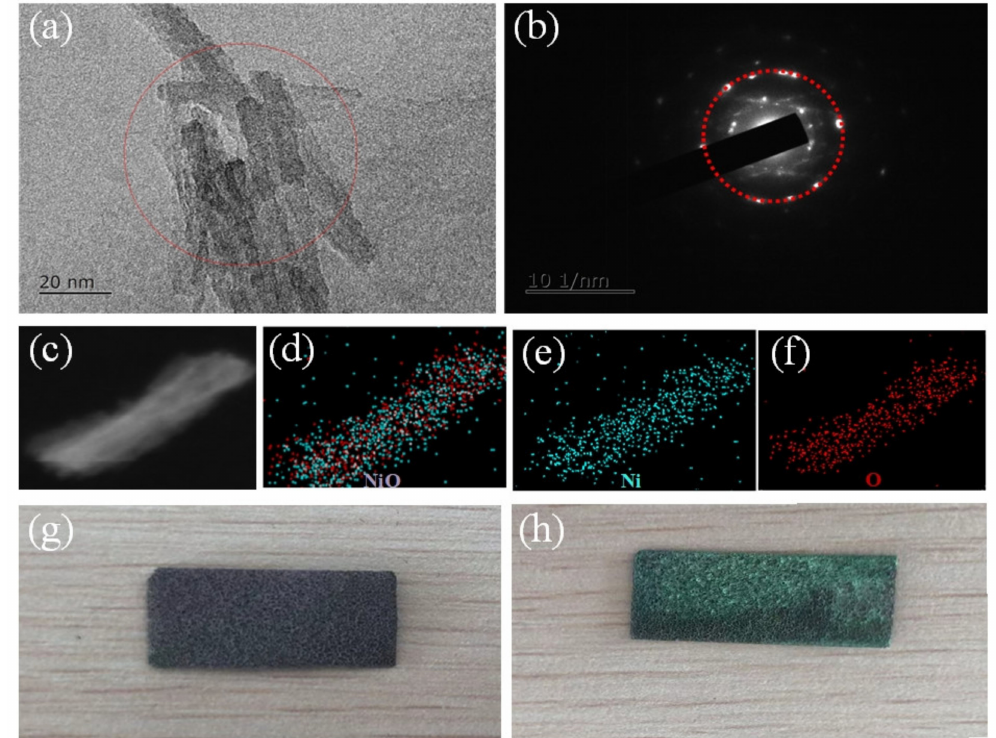
Figure 6. ( a ) TEM of NiO, ( b ) the corresponding SAED pattern, ( c – f ), STEM-EDX elemental mappings of NiO, ( g , h ) Photos of foamed nickel before and after electrophoretic